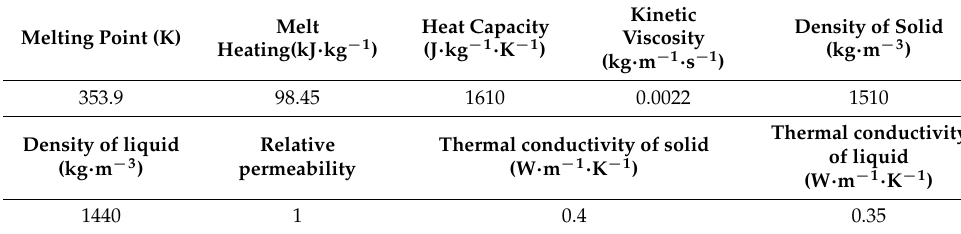
Table 1. The material properties of TNT.